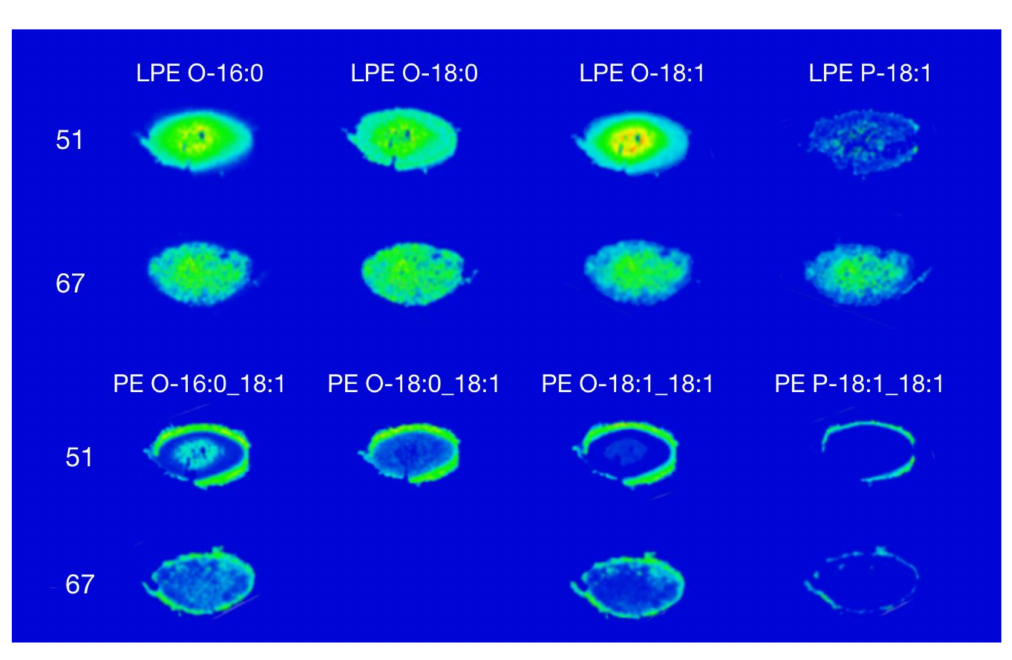
Figure 1. Distribution of lysophosphatidylethanolamine (LPE) and the most abundant phosphatidylethanolamines (PEs) in a 51-year-old and 67-year-old human